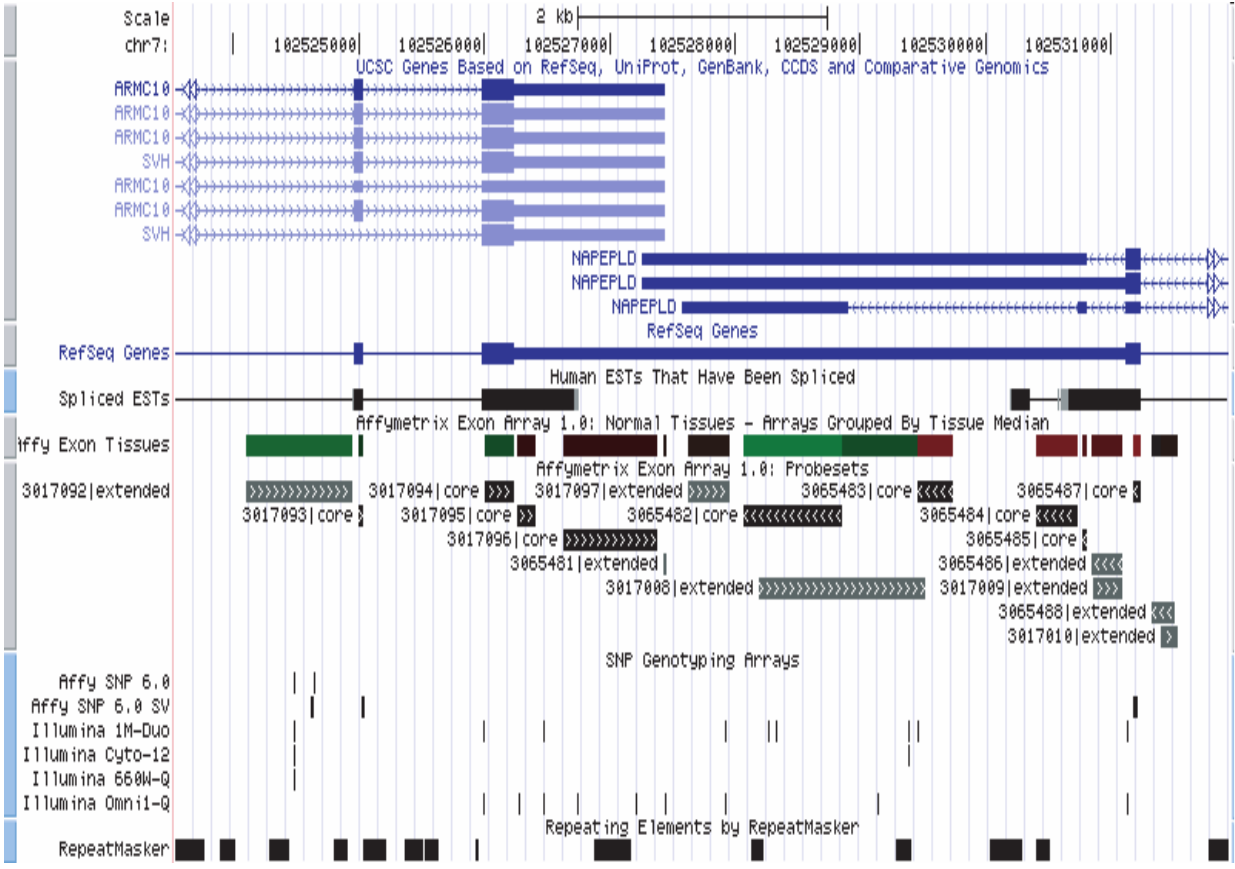
Figure 3. A differentially spliced probeset that could be affected by novel SNPs. The probeset 3017096 (chr7: 102526627–102527377) has a novel SNP (chr7: 102526628) in the CEU samples. The probeset was originally found to be differentially spliced between the CEU and YRI samples. UCSC Genome Browser (http://genome.ucsc.edu/) was used to plot the genomic positions (hg18, March, 2006) of the probeset in relation to the other probesets for the ARMC10 gene. This novel SNP lies within the probe chr7:102526627–102526651.